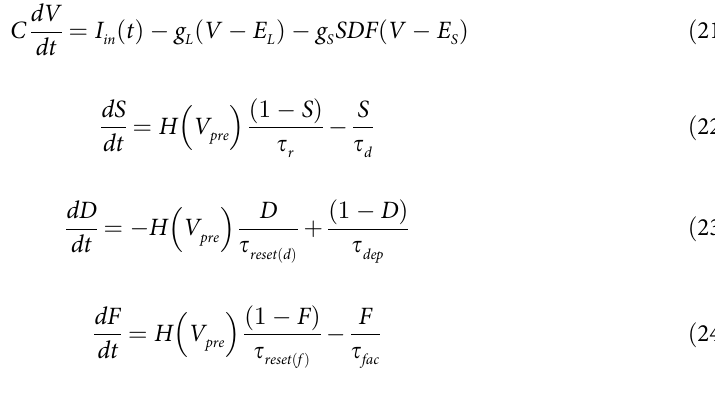
Fig 4C : 0.08 Fig 4DE :